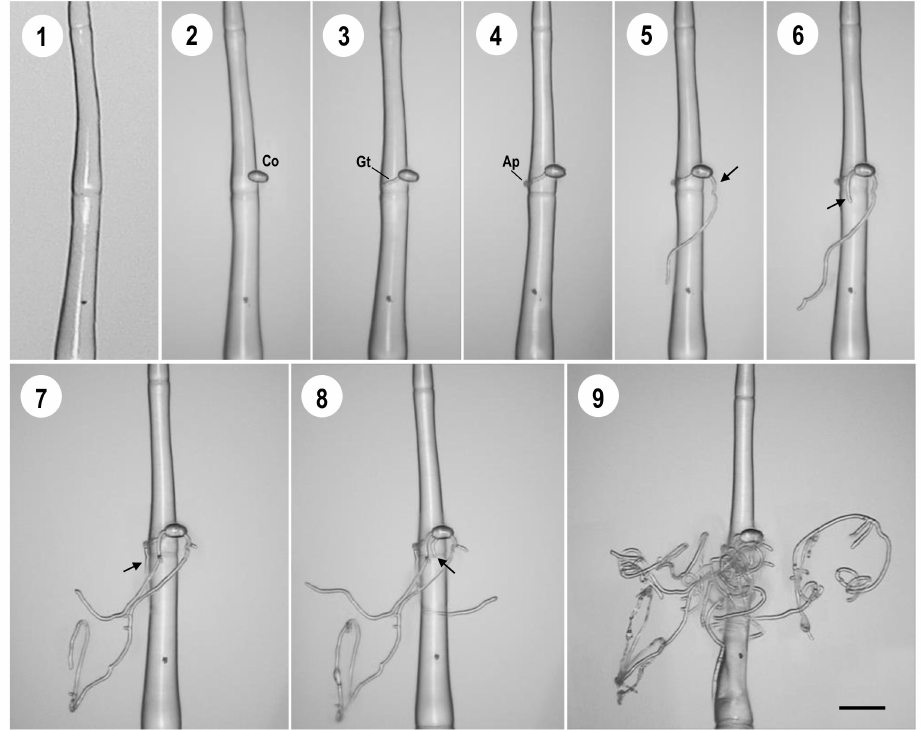
Figure 2. Infection processes of KTP-03 on leaf type I trichome cells of MM observed continuously with a KH-2700 DM. ( 1 ) and ( 2 ) Micrographs were acquired before ( 1 ) and after inoculation with a KTP-03 conidium (Co) onto single leaf type I trichome cells ( 2 ). ( 3 – 9 ) Micrographs were recorded at ( 3 ) 3 h, ( 4 ) 6 h, ( 5 ) 2 days, ( 6 ) 3 days, ( 7 ) 4 days, ( 8 ) 5 days, and ( 9 ) 12 days after inoculation